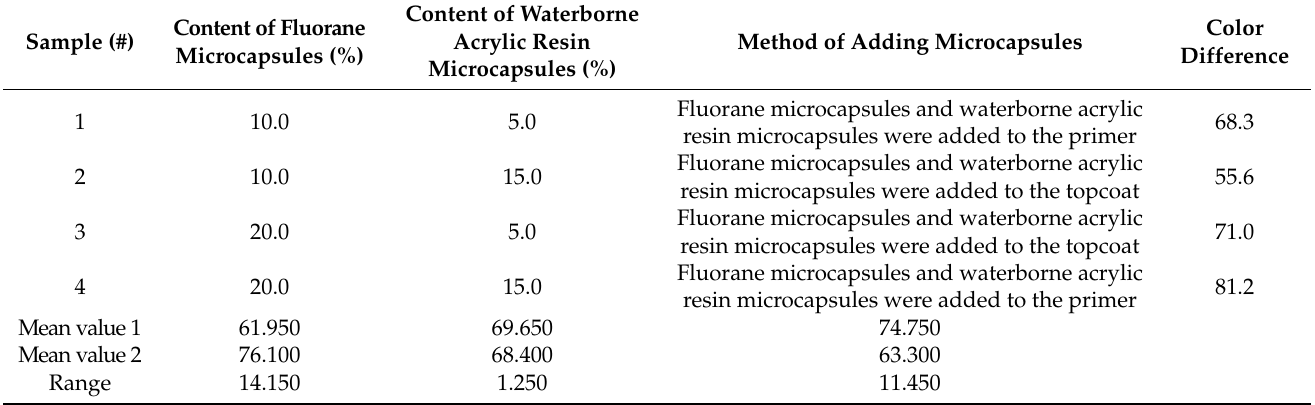
Table 3. Range results of the coating film color